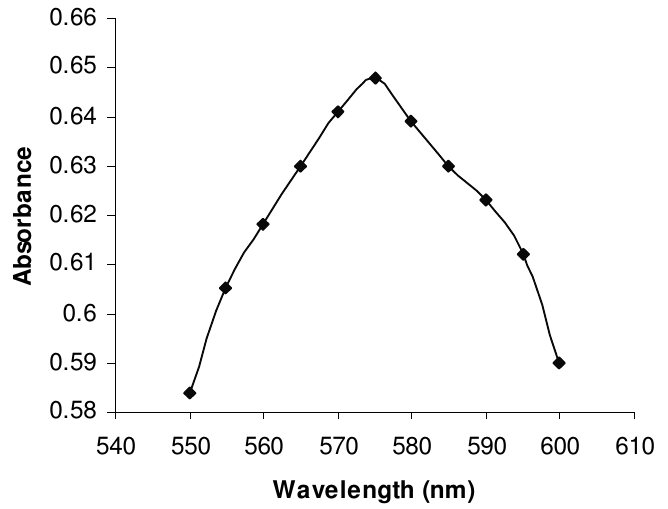
Figure 2. Absorption spectrum of reaction product between alfuzosin (Final concentration 50 µ g/mL) and ninhydrin.